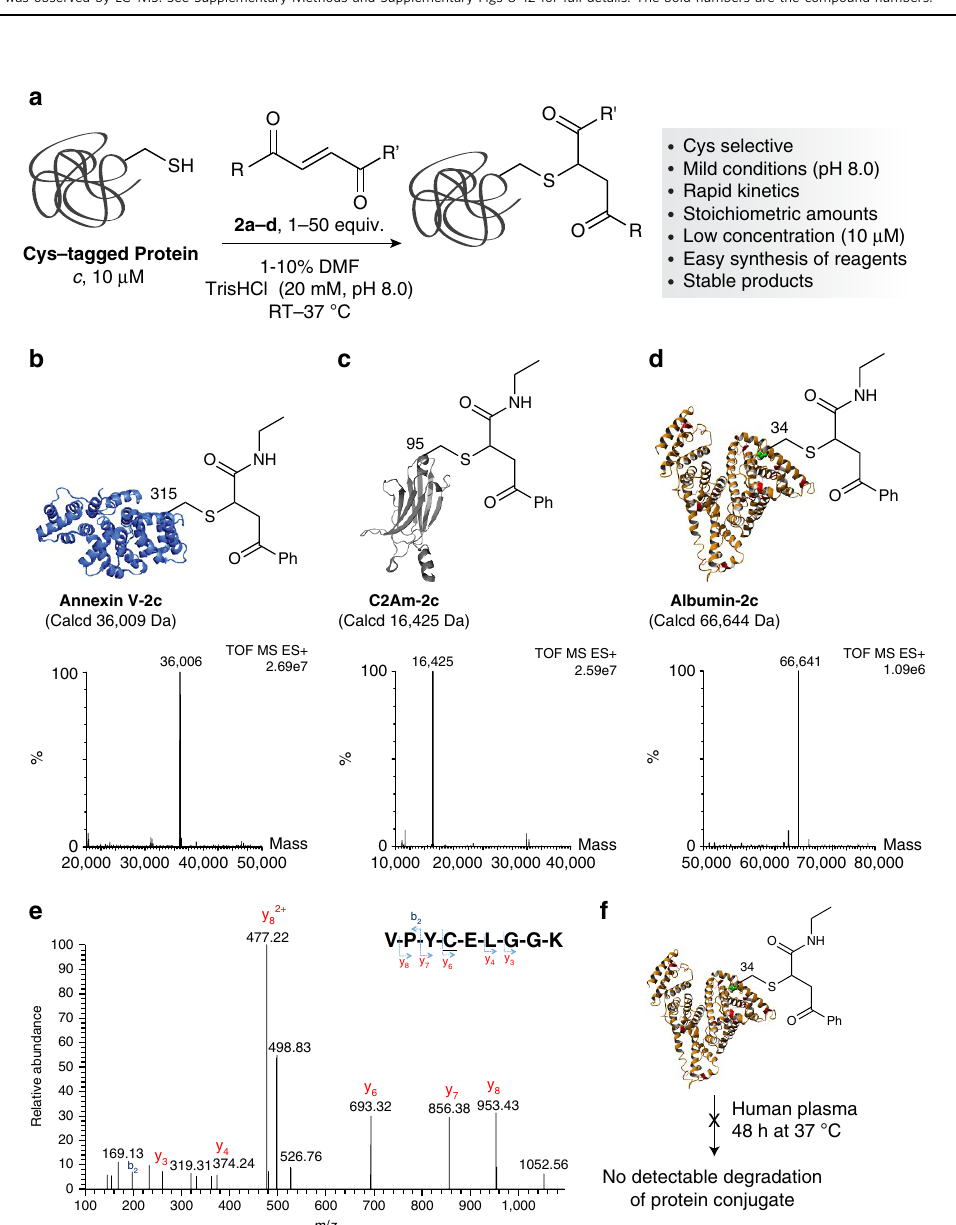
Figure 2 | Protein Cys bioconjugation with carbonylacrylic reagent 2c. ( a ) Schematic of the reaction of Cys-tagged proteins with carbonylacrylic reagents 2a – d . ( b – d ) Electrospray ionization–MS spectra of conjugates ( b ) Annexin V- 2c , ( c ) C2Am- 2c and ( d ) Albumin- 2c . ( e ) MS/MS spectrum of the m/z 526.75 doubly charged ion of the tryptic peptide VPYCELGGK, containing the modification at the Cys residue of C2Am- 2c . The generated C -terminal y fragment ions (y6–y8) are consistent with the mass of the modification. ( f ) The albumin- 2c conjugate remains intact when exposed to exogenous (GSH) thiols and in plasma as assessed by LC–MS. See Supplementary Fig. 21. RT, room temperature; DMF, dimethylformamide.